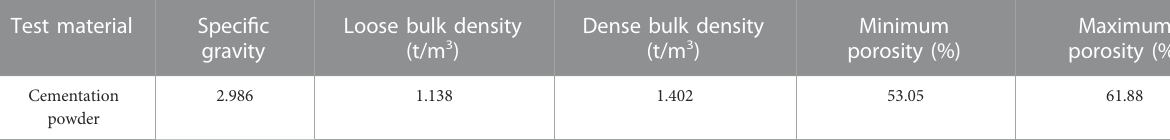
TABLE 2 Determination values of physical properties of cementation powder.